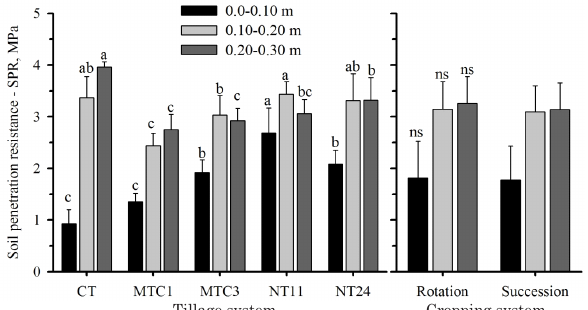
Figure 6. Soil penetration resistance of the tillage and cropping systems when the fraction of plant-available water reached 0.7. ns Not significant in each layer by the F-test (p<0.05); Means followed by the same letter, uppercase between tillage systems, and lowercase in the same tillage or cropping systems, do not differ by Tukey’s test (p <0.05). CT: conventional tillage system; MTC 1 : minimum tillage, annual chiseling; MTC 3 : minimum tillage, chiseled every three years; NT 11 : no-tillage for 11 years; NT 24 : no-tillage for 24 years. Vertical bars indicate standard deviation from the